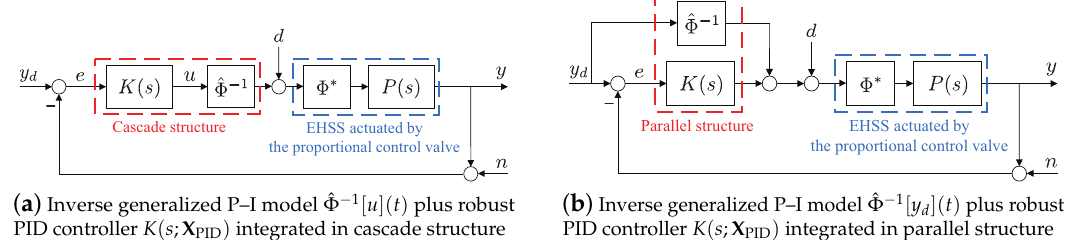
Figure 14. Block diagrams of the feedforward plus feedback control system.